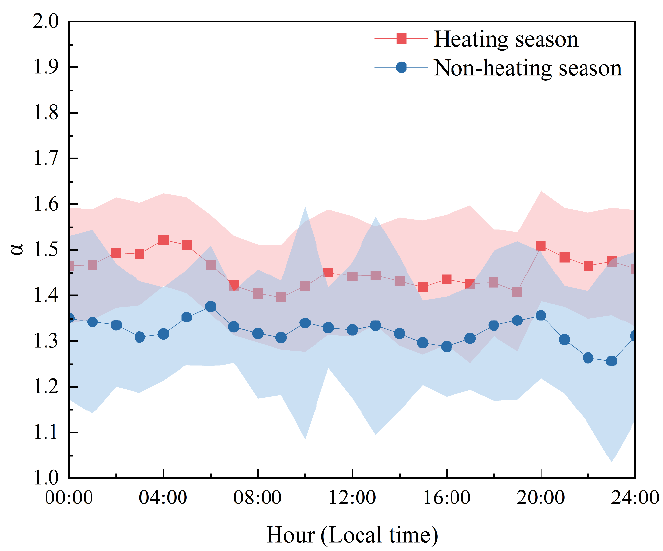
Figure 6. Average daily change in α -values between the heating and non-heating seasons.